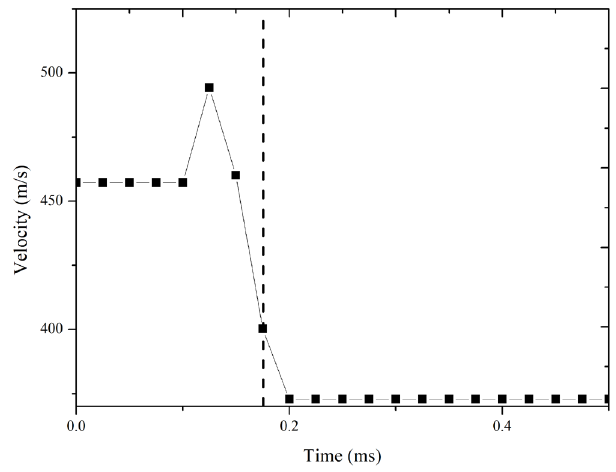
Figure 7. AMMO 2 specific velocity for each time steps graph.